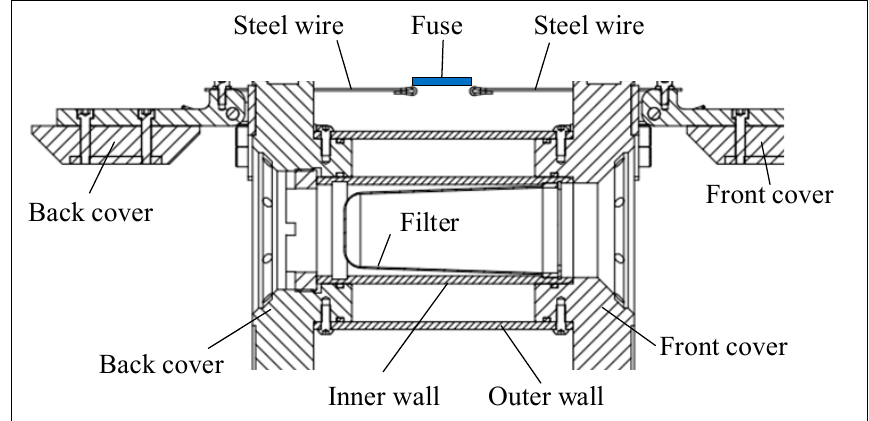
Figure 8. Cross-sectional view of the insulation tube.